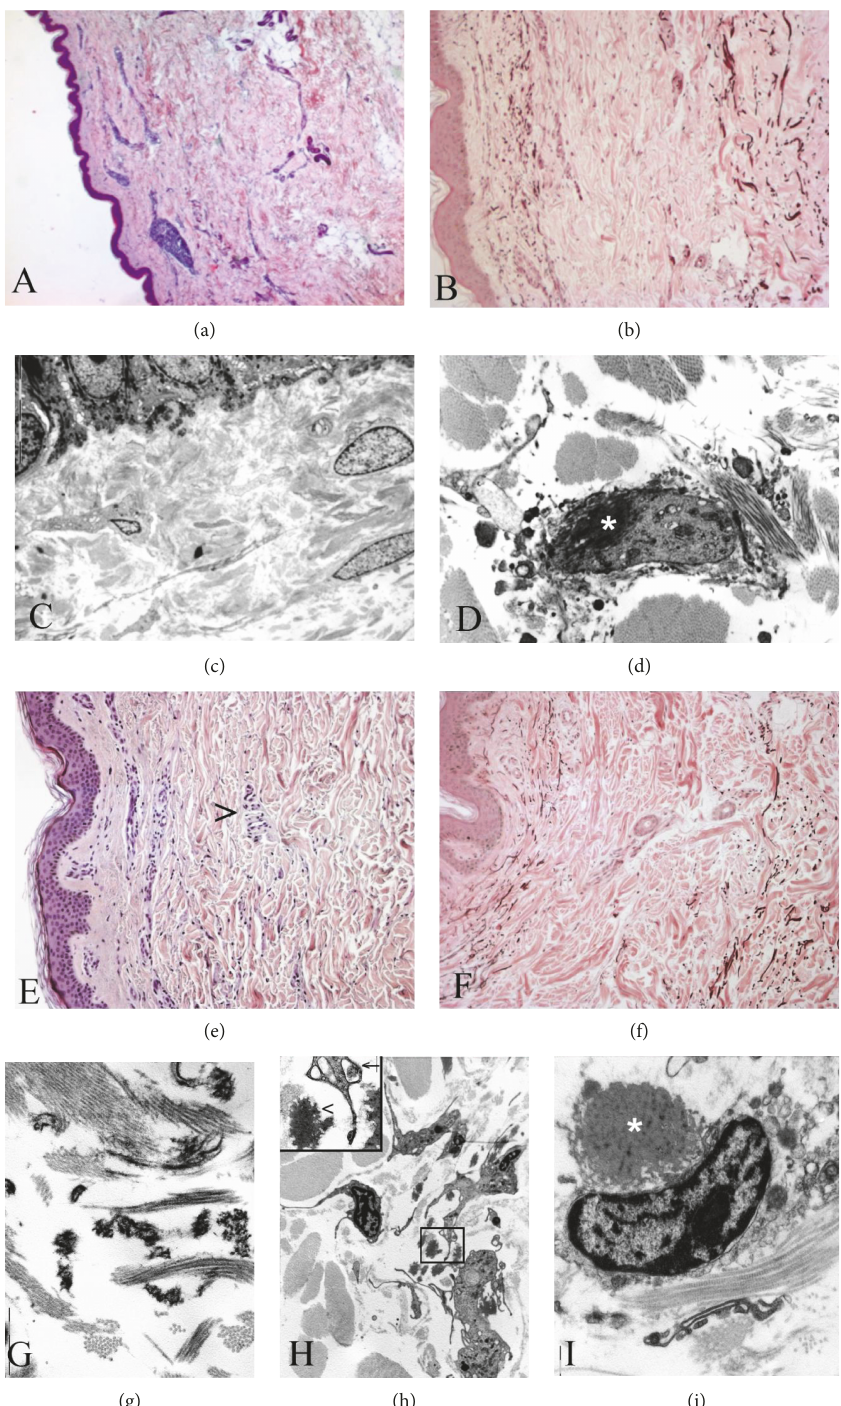
Figure 1: (a – d) Skin biopsy from patient number 1. In fl ammatory in fi ltrates in the upper dermis (a and b) are associated with small areas of elastinolysis in the middermis (b). At TEM examination, there is an almost complete loss of elastic fi bres in the middermis. No alterations are seen in the upper dermis (c). Elastophagocytosis (white star) by macrophages can be also appreciated (d). (a) H&E stain, × 40; (b) Giemsa- Orcein stain, × 100; (c) and (d) uranyl acetate & lead citrate, original magni fi cation × 13.000. (e – i) Skin biopsy from patient number 2. Large in fl ammatory in fi ltrates are present in the middermis (e) where a band-like loss of elastic fi bres can be appreciated (f). At TEM examination, a fragmentation of elastic fi bres is evident in the middermis (g) ((h), inset arrowhead) where a lot of activated macrophages with an irregular surface are scattered within the extracellular matrix (h). Several macrophages are engaged in elastophagocytosis ((i), white star; (h), inset, arrow). (e) H&E stain, × 100; (b) Giemsa-Orcein stain, × 100; (g – i) uranyl acetate & lead citrate, (g) and (i) original magni fi cation × 13.000, (h) original magni fi cation ×